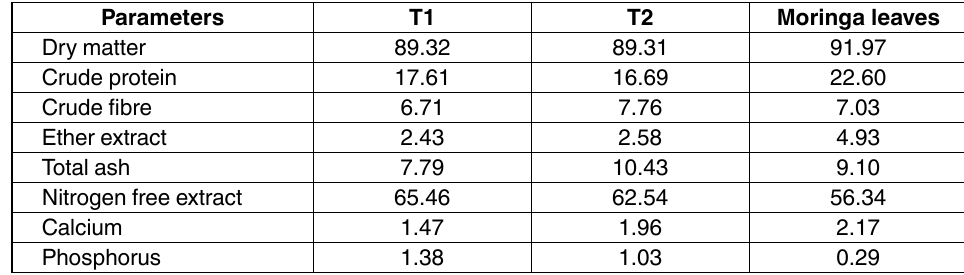
Table 2. Proximate composition of experimental rations and Moringa leaves (%) on dry matter